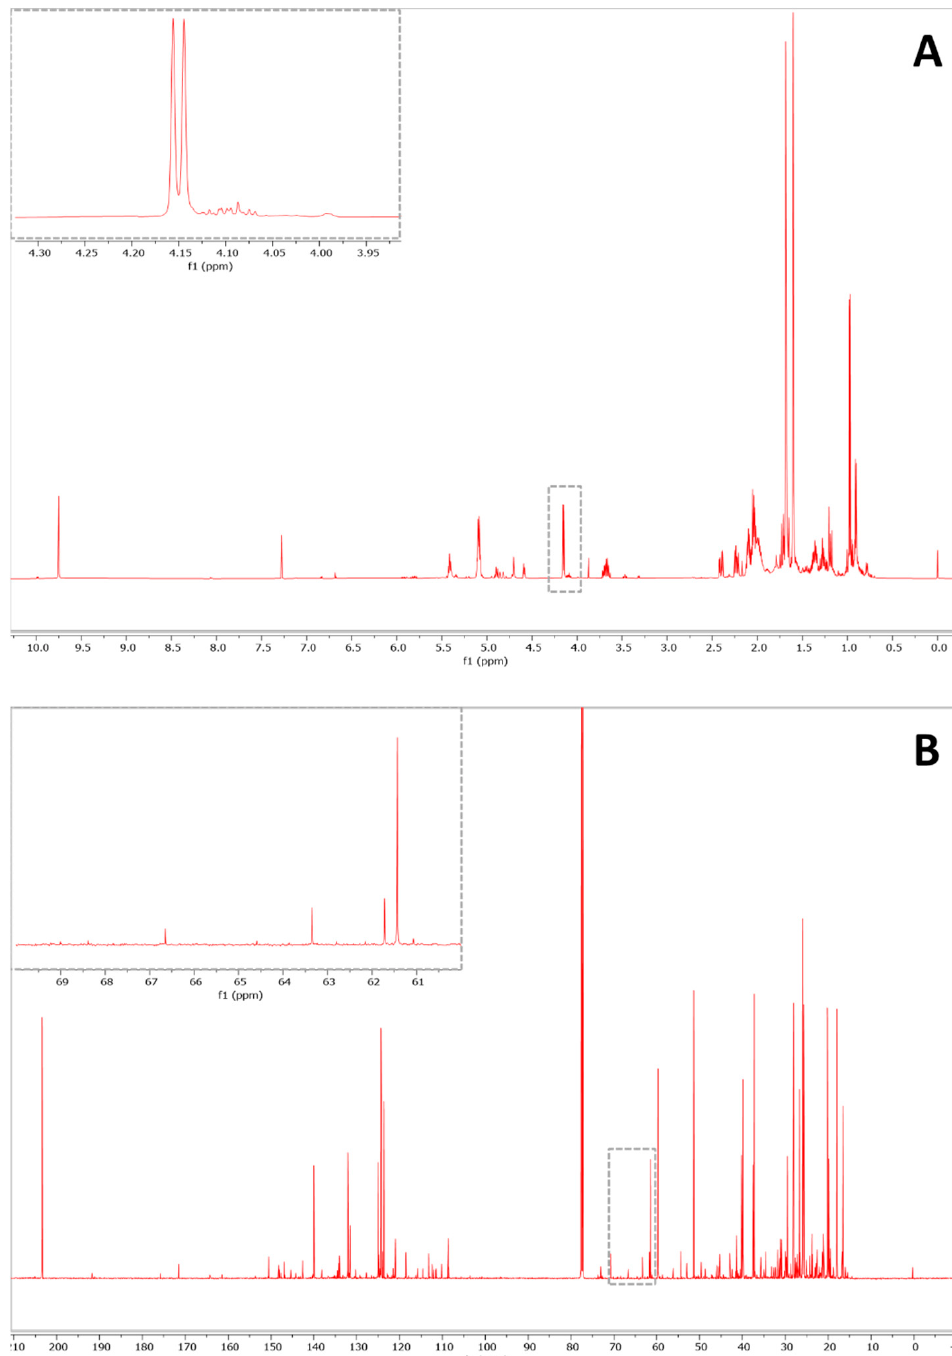
Figure 2. 1 H-NMR and 13 C-NMR spectra of citronella EO. Enlargements on the typical chemical shifts of glycerol backbone signals.